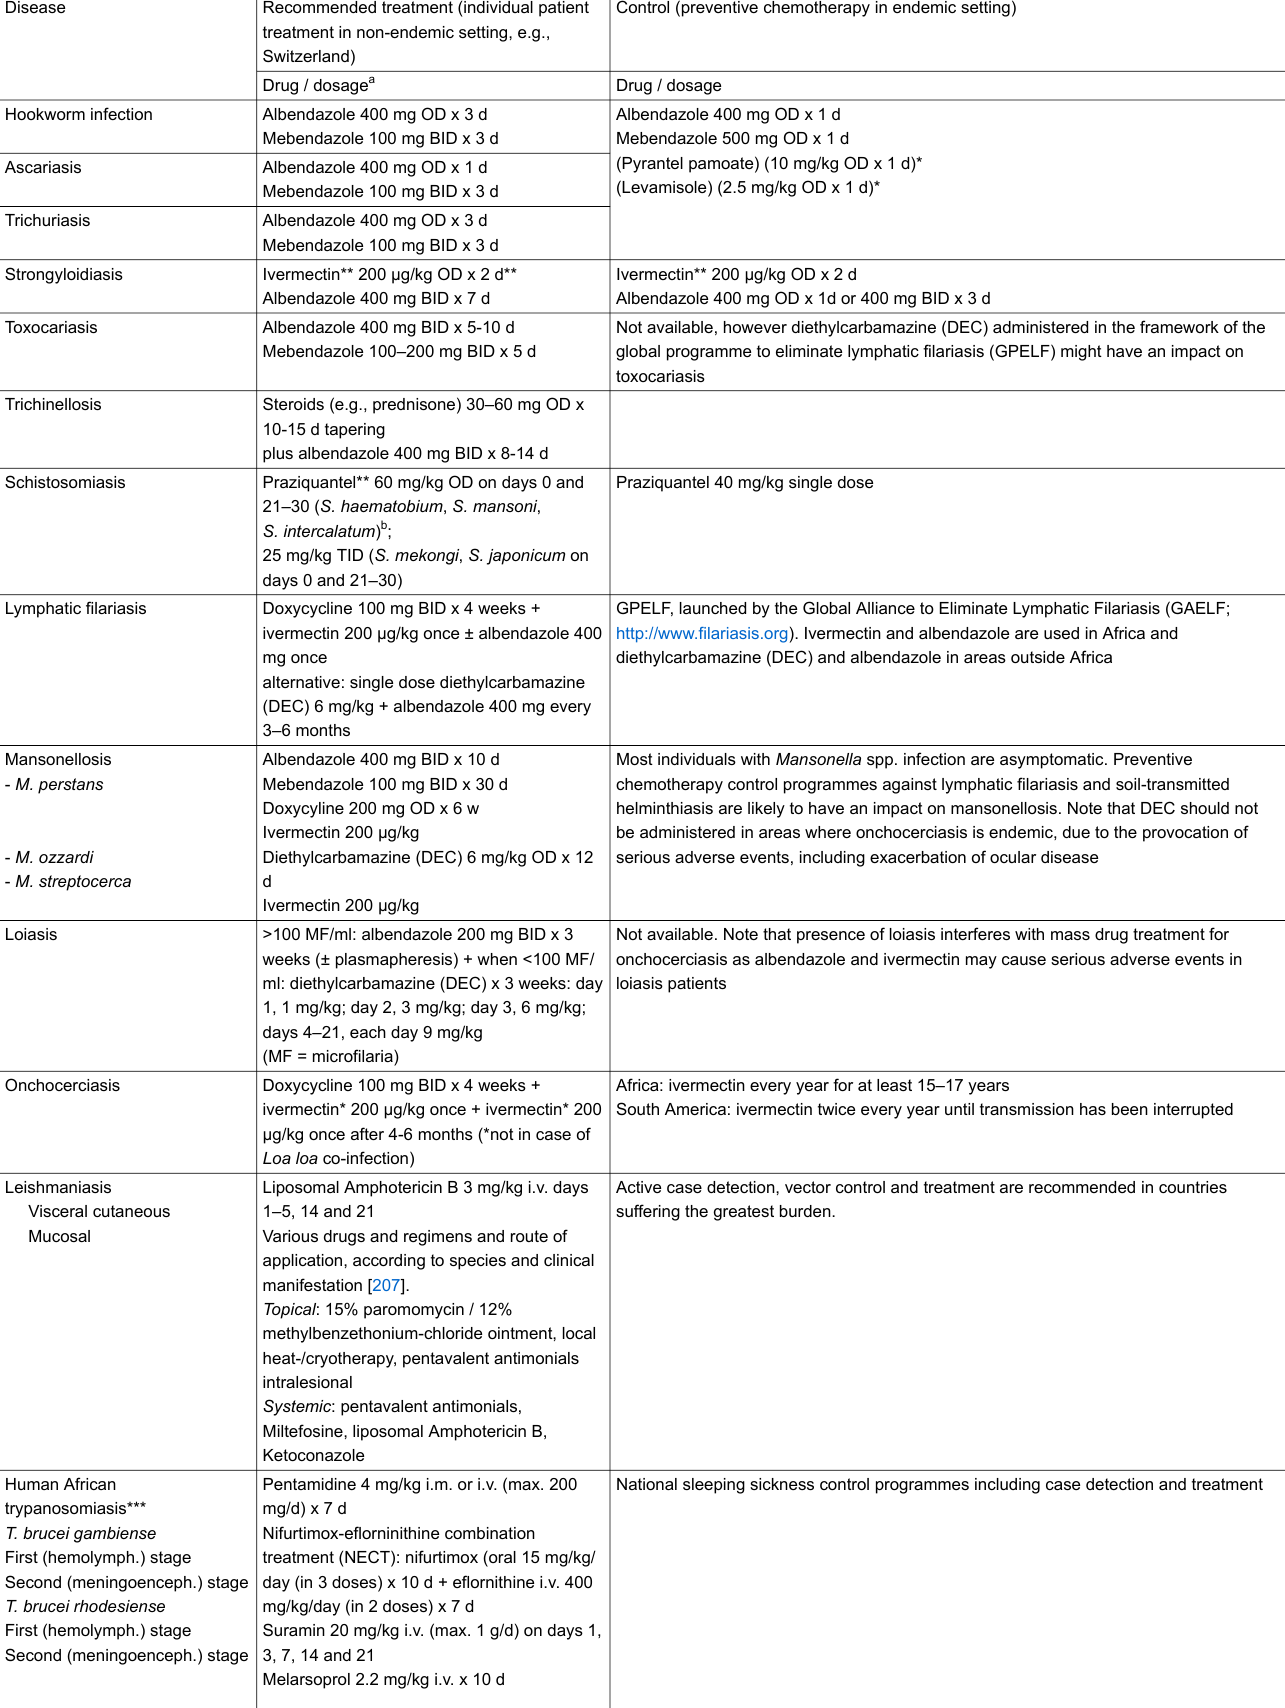
Table 5: Recommended treatment for selected neglected tropical diseases, juxtaposing the situation in Switzerland (typical non-endemic setting) with large-scale control emphasising preventive chemotherapy (in highly endemic settings). Recommended treatment (individual patient Control (preventive chemotherapy in endemic setting)Disease treatment in non-endemic setting, e.g., Switzerland)